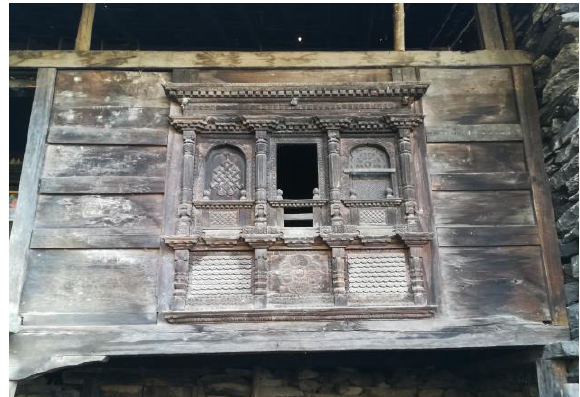
Figure 9. Wood facade